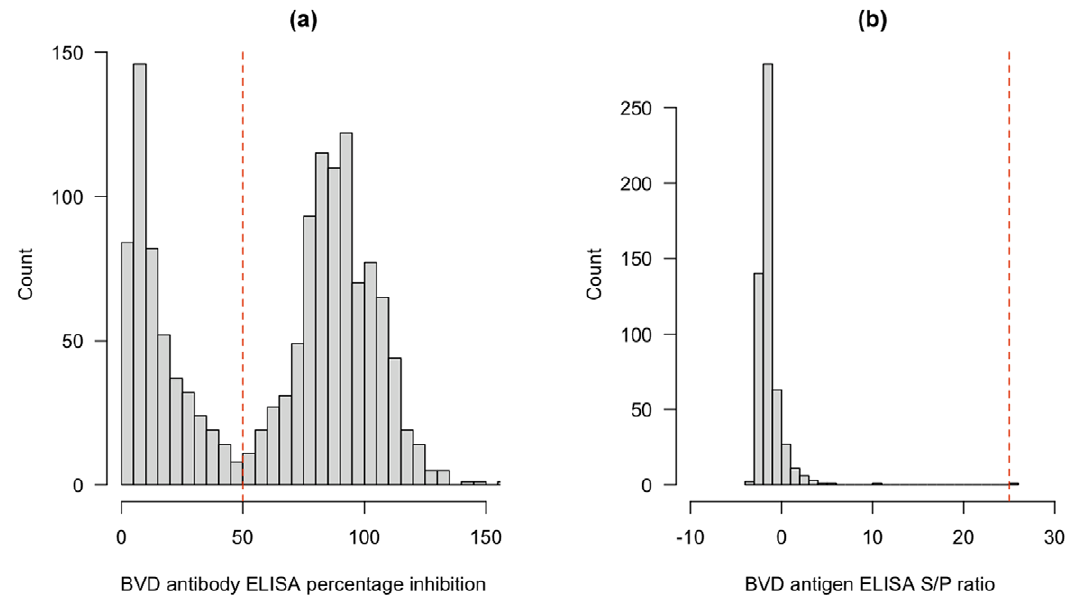
Figure 2. Histogram showing the number of animals against their percentage inhibition values for the BVD antibody ELISA and the sample/positive control (S/P) ratio for the antigen ELISA.